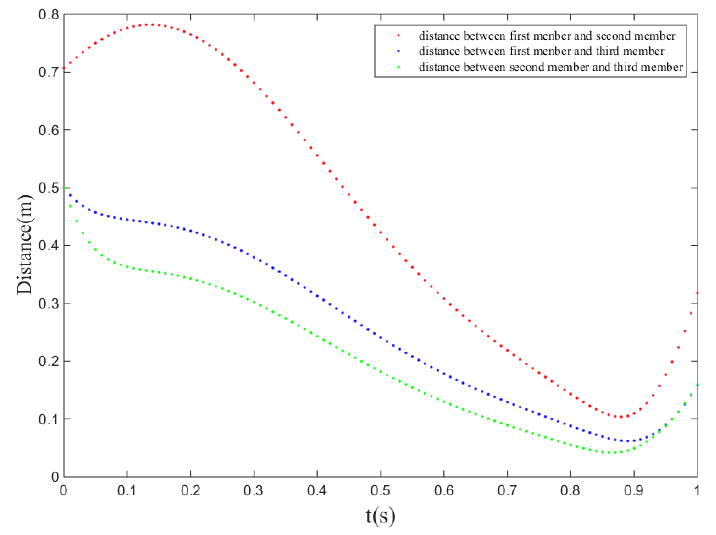
Figure 4. Distance between cluster members with parameters ω = 0.1, β 1 = 5.87, β 2 = 5.88, β 3 = 5.85, κ 12 = 1.03, κ 13 = 1.05, κ 23 =